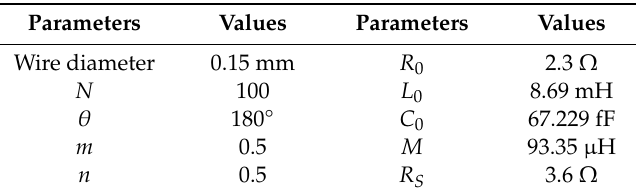
Table 5. Parameters of the D-HFCT sensor.